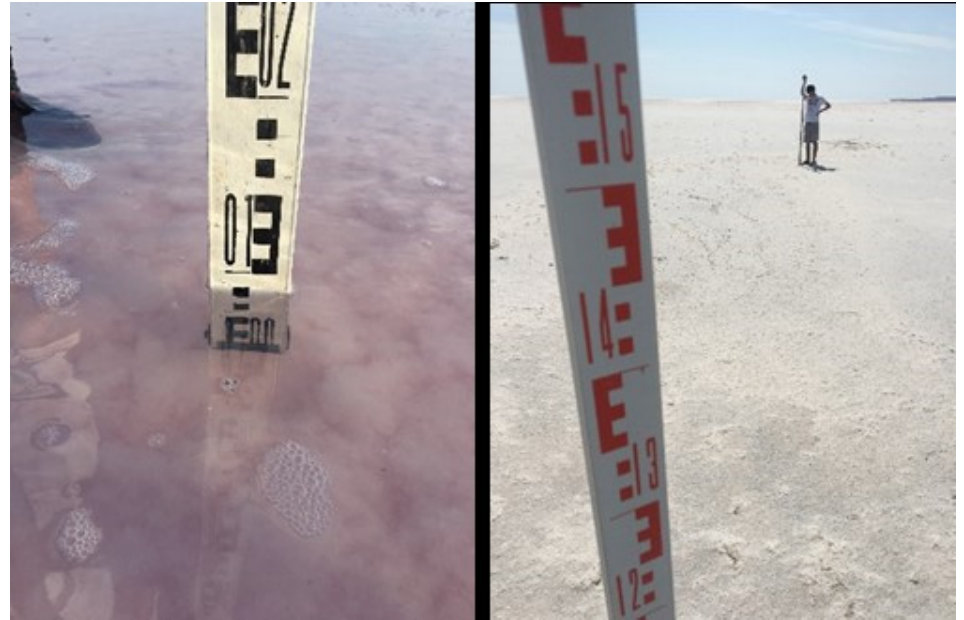
Figure 5. Examples of levelling measurements during wet and dry season (The left picture shows a 9 cm water depth; the right picture shows the salt surface.). 9 cm water depth; the right picture shows the salt